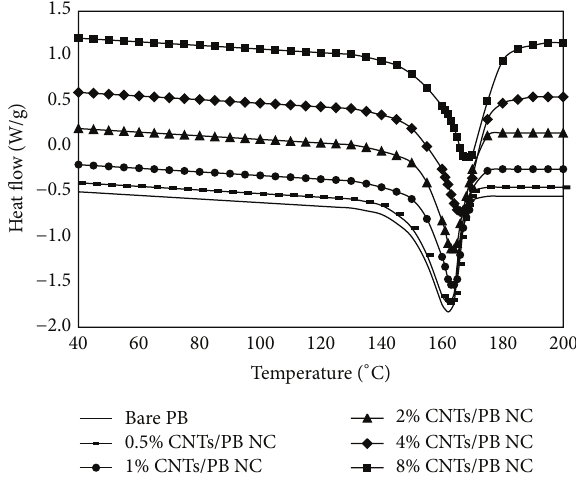
Figure 3: DSC curves of unfilled PB and CNTs/PB nanocomposites containing 0.5, 1, 2, 4, and 8 wt.% CNTs.